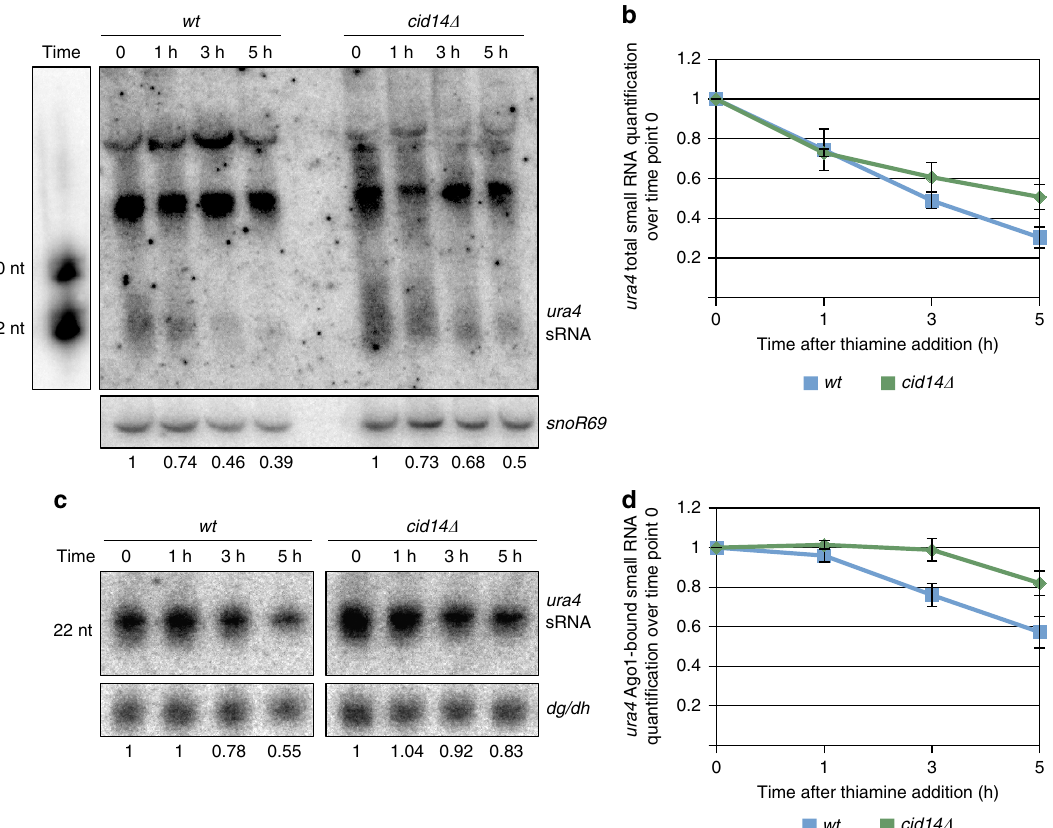
Figure 6 | Argonaute-bound sRNAs are more stable in cid14 D cells. ( a ) Northern blotting showing ura4 sRNAs isolated from total sRNA fraction from the indicated strains. ura4 sRNAs were normalized to snoR69 shown in the lower panel. Quantification is relative to time point 0 when thiamine was added and is shown below the image. ( b ) Quantification of ura4 sRNAs from total sRNA fraction in wild type and cid14 D cells. Quantification is relative to time point 0 when thiamine was added. ura4 sRNAs were normalized to snoR69 . Error bars indicate s.e.m. of three independent experiments. ( c ) Northern blotting showing Argonaute-bound ura4 sRNAs isolated from wild type and cid14 D cells. In cid14 D cells, ura4 sRNAs have longer half-life than in the wild-type cells. Argonaute-bound ura4 sRNAs were normalized to centromeric sRNAs shown in the lower panel. Quantification is relative to time point 0 when thiamine was added and is shown below the image. ( d ) Quantification of Argonaute-bound ura4 sRNAs in wild type and cid14 D cells. ura4 sRNAs were normalized to centromeric siRNAs. Quantification is relative to time point 0 when thiamine was added. Error bars indicate s.e.m. of three independent